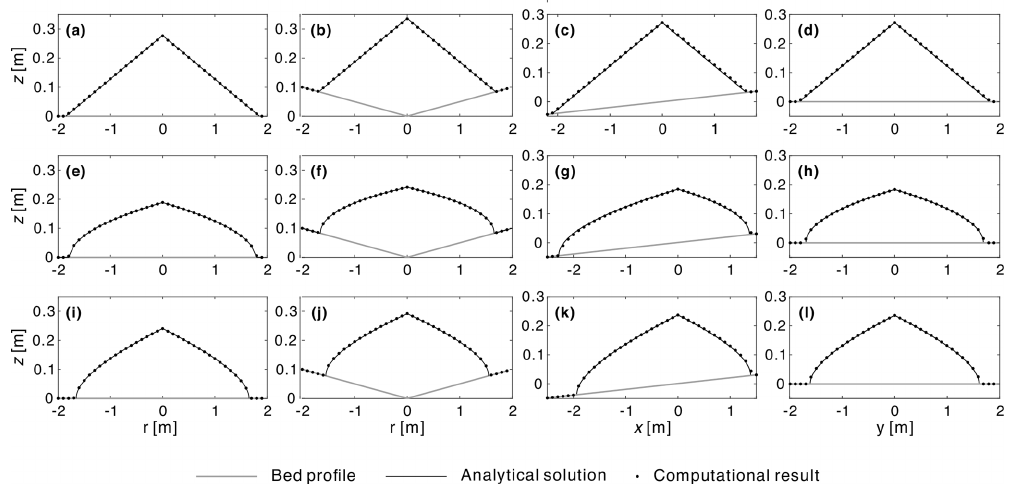
Figure 6. Comparison between computational and analytical solutions for different material parameters and geometries: ( a , e , and i ) radial deposit profiles on a horizontal plane, ( b , f , and j ) radial deposit profiles on a conical basin, ( c , g , and k ) longitudinal deposit profiles on an inclined plane, ( d , h , and l ) transverse deposit profiles on an inclined plane, (a–d) deposit with friction angle and no yield (tan φ = 0 . 15, τ Y / ( ρg ) = 0m), (e–h) deposit with yield stress and no friction angle (tan φ = 0, τ Y / ( ρg ) = 0 . 01m), and (i–l) deposit with both friction angle and yield stress (tan φ = 0 . 05, τ Y / ( ρg ) = 0 . 01m).